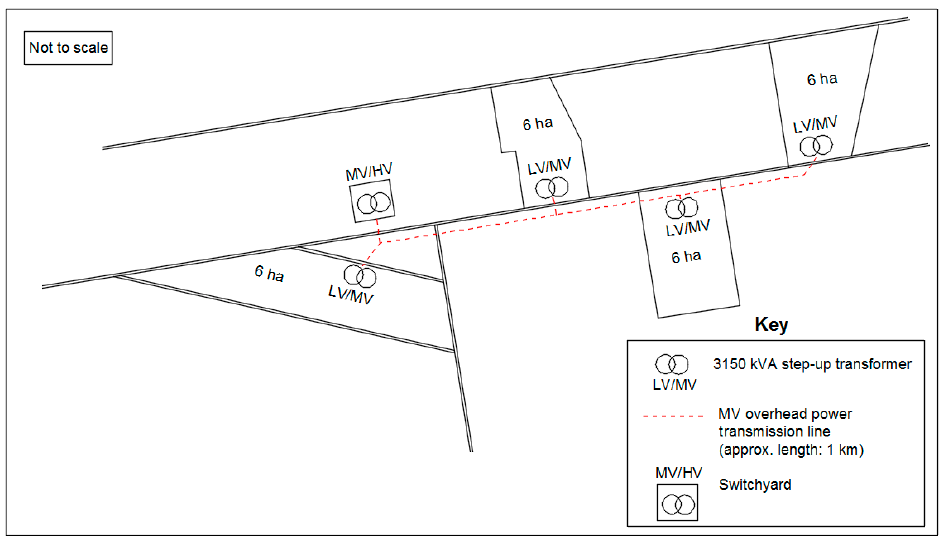
Figure 1. Spatial distribution of the four plots totalizing 24 ha, the medium voltage power transmission line budgeted and the pre-existing grid-connection switchyard.